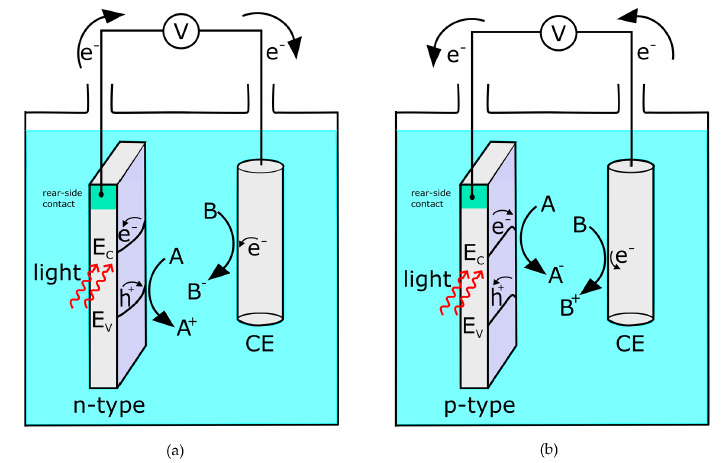
Figure 1. ( a ) n-type semiconductor as a photoanode in contact with a counter electrode (CE): At